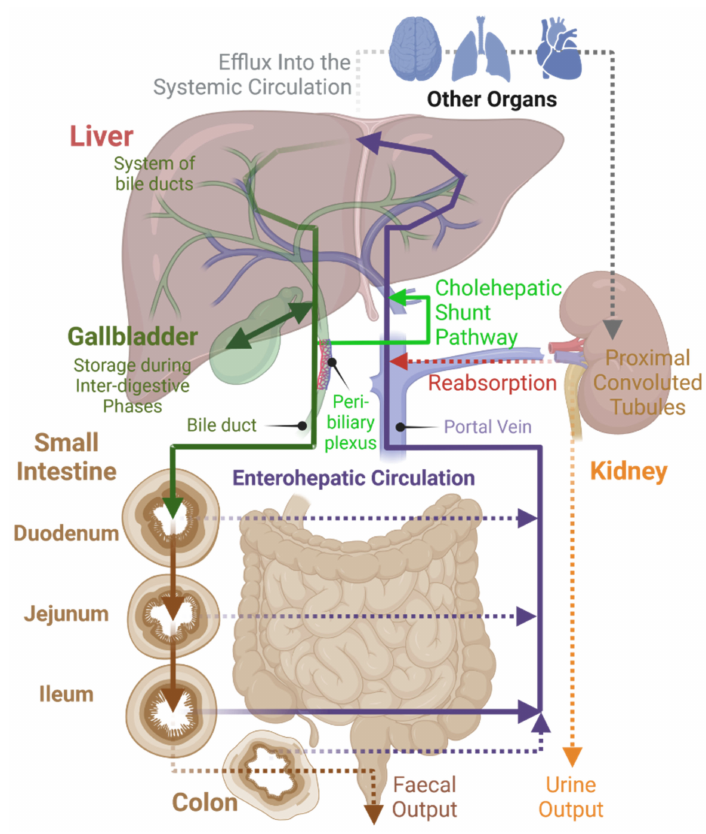
Figure 3. Enterohepatic circulation. Created with